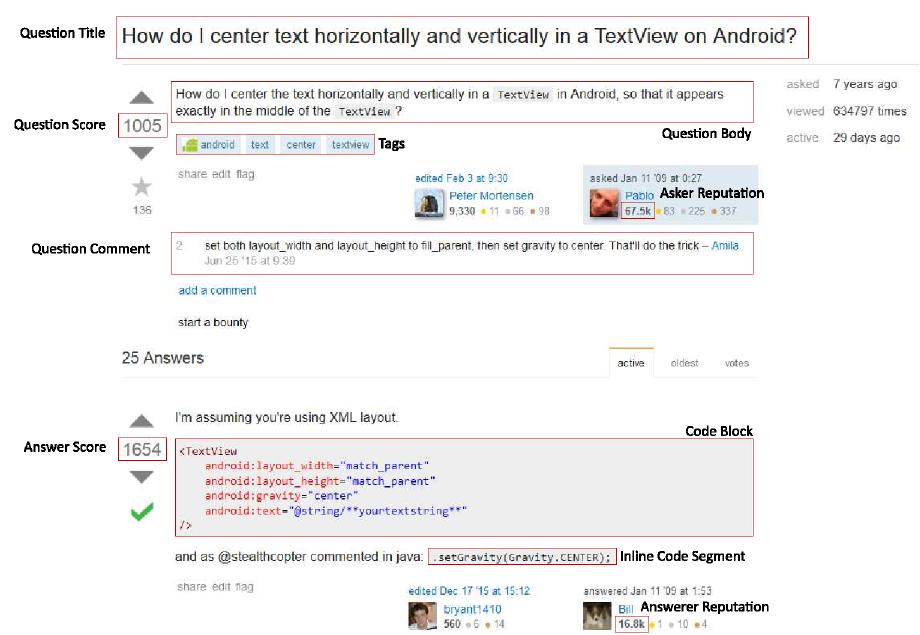
Fig 1. A question and answer on Stack Overflow. Some relevant variables are outlined in